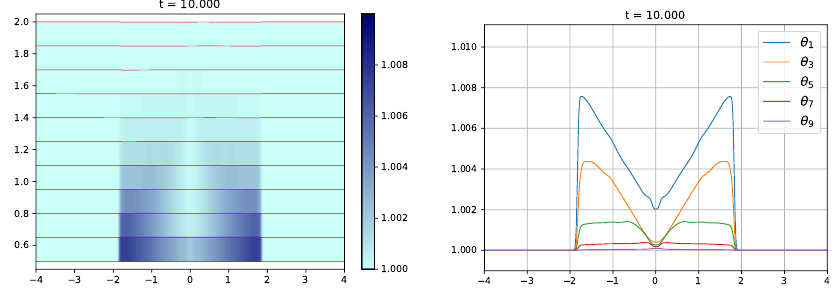
Figure 16. Evolution of the relative density at t = 10